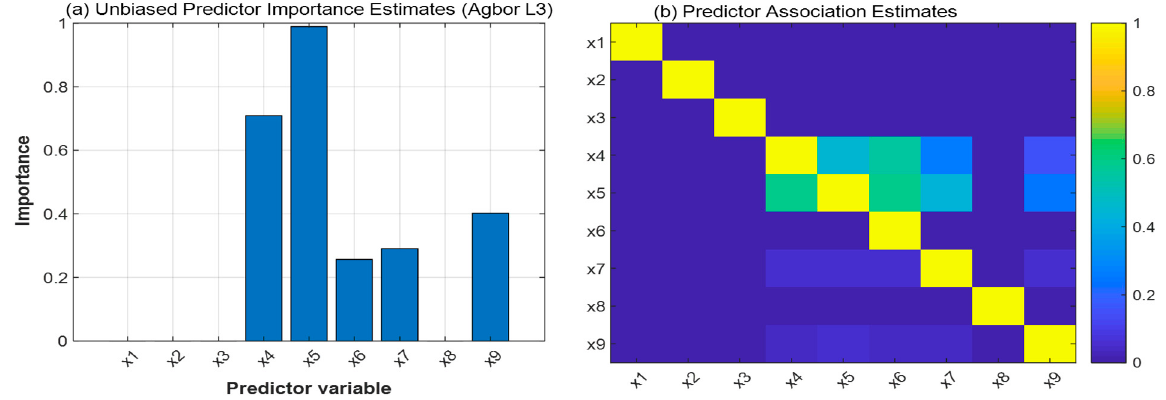
Figure 7. The constituent feature (predictor) selection of the important estimates and their association using RF. ( a ) Unbiased predictor importance estimates for Agbor L3. ( b ) Predictor association estimates.